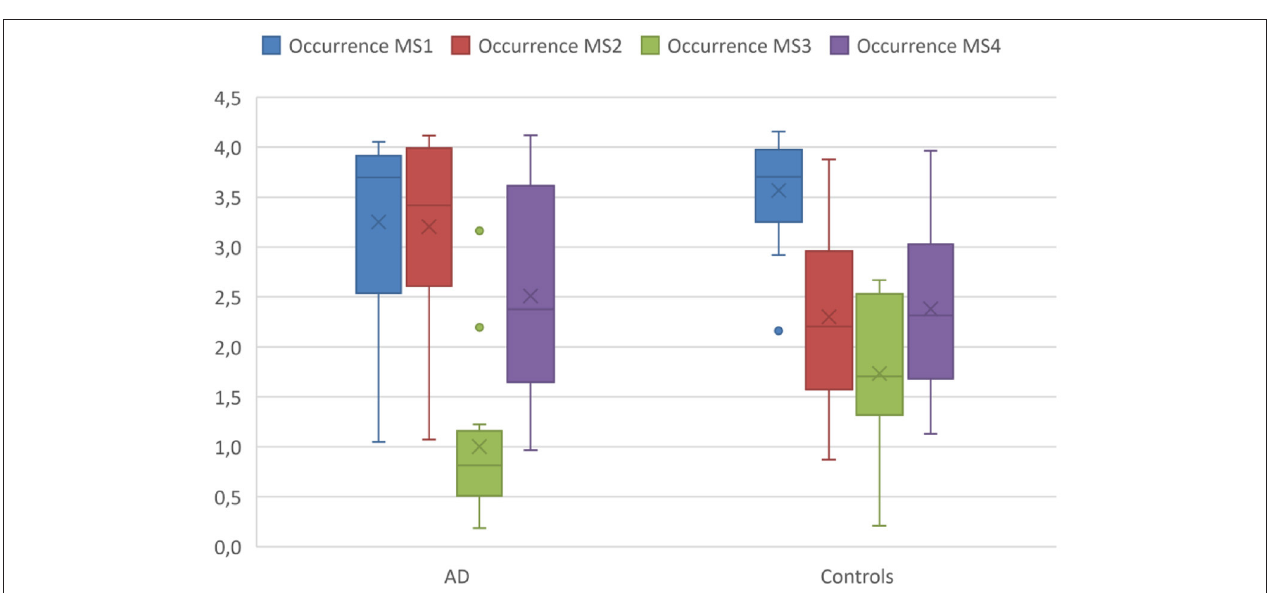
FIGURE 1 | Occurrences of microstates in AD patients and controls. Boxplot of occurrences of microstates per second averaged across the entire acquisition period comparing the AD group with the controls. Boxplots show 1st quartile, median, and 3rd quartile as well as mean values (large cross).